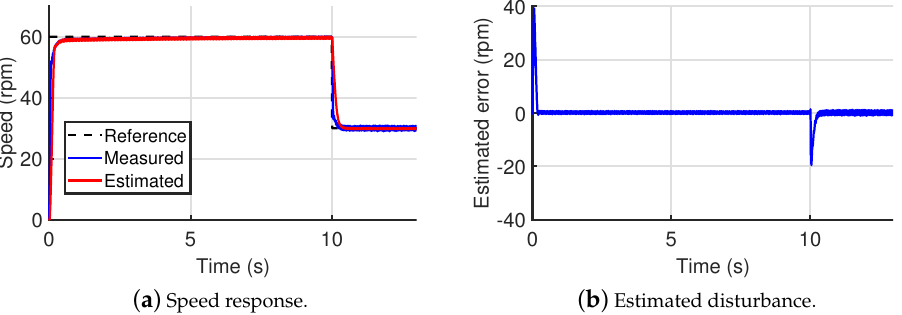
Figure 20. Experimental results of STA under 60 rpm to 30